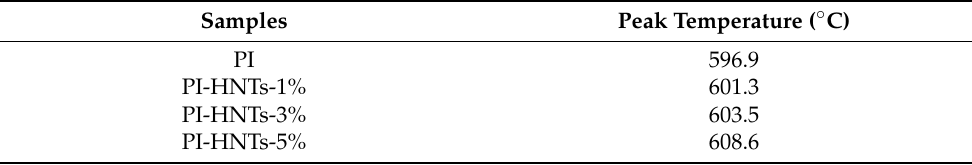
0.81.21.6 Figure 9. Moisture absorption of PI, PI-HNTs-1%, PI-PHNTs-1%, PI-HNTs-3%, and PI-HNTs-5%. 0.00.4